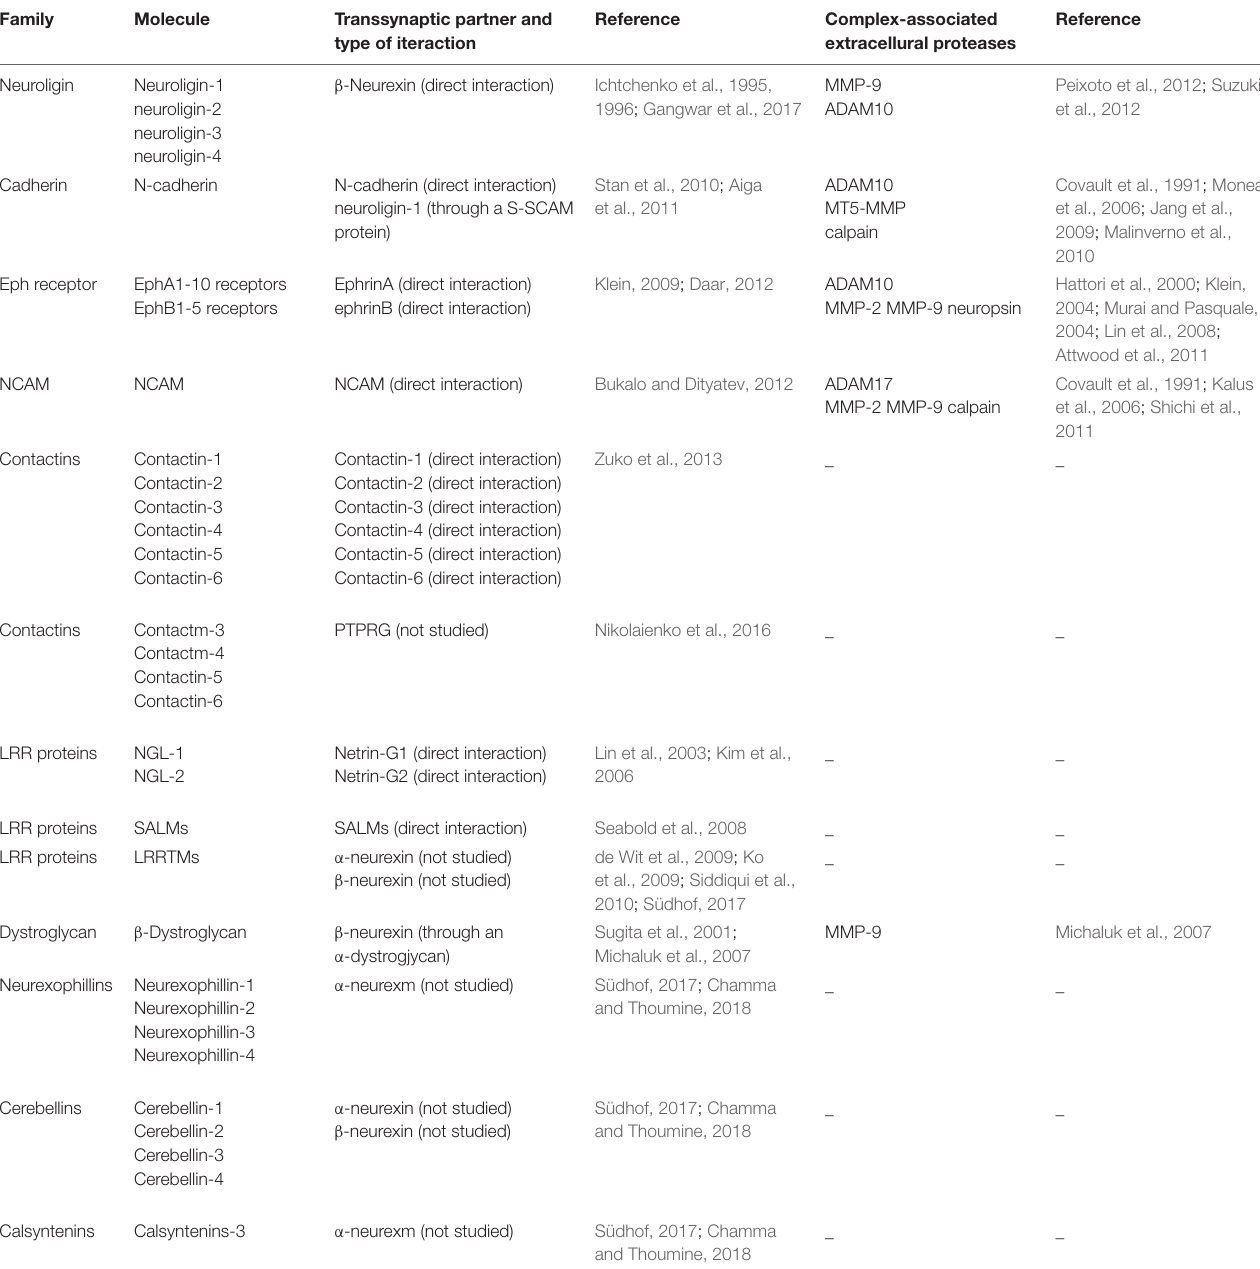
TABLE 1 | Trans-synaptic molecules, their partner proteins, and associated proteases involved in synaptic function. Family